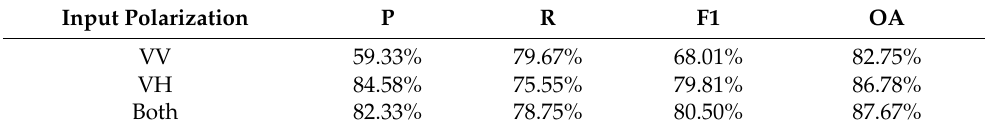
Figure 7. Binary burn map of SG-FCM-DCNN using ( a ) VV, ( b ) VH, and ( c ) both polarizations and their corresponding confusion images at ( d – f ). Table 2. Performance of the SG-FCM-DCNN using VV, VH, and both polarizations as the model